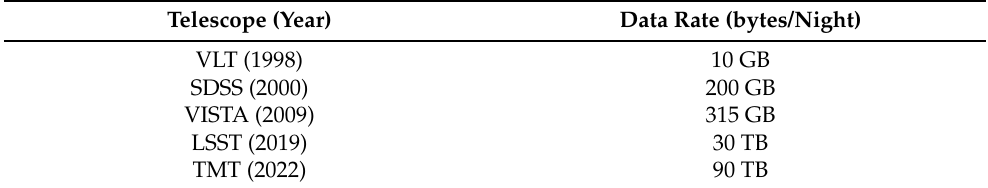
Table 1. Amount of data from existing and upcoming telescopes